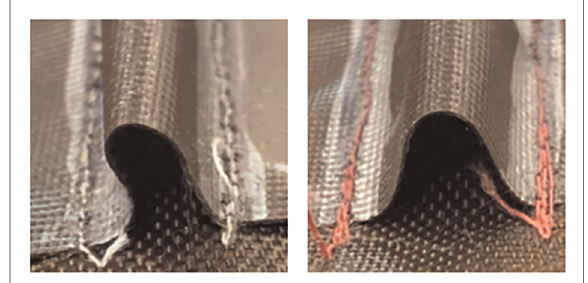
FIGURE 8 The approximate cross-sectional area shape for 6 (cid:3) 8 (left) and 10 (cid:3) 8 (right) channels. The sides of the 6 (cid:3) 8 channel cave in compared to a channel where the width is larger than the